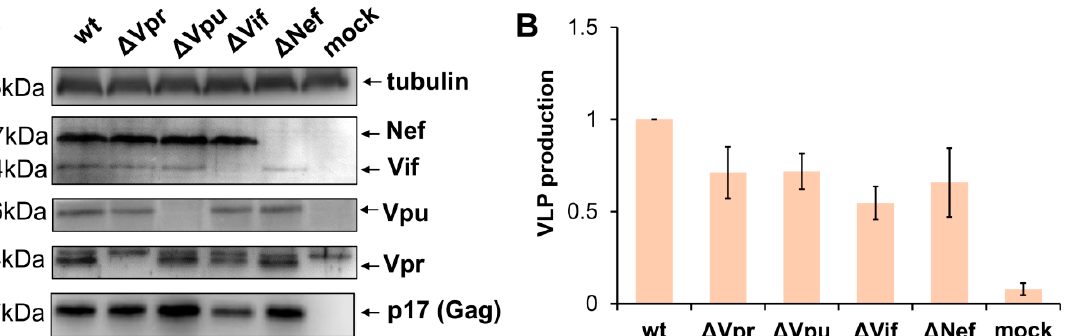
Figure 1. Characteristics of the generated accessory gene mutants of HIV-1. ( A ) Western blot analysis of HIV-1 accessory protein expression in 293T cells transiently transfected with the original (wt) pCMV-dR8.2 packaging plasmid or the plasmid containing mutation in one of the accessory genes (indicated as ∆ ) or mock plasmid. The blots were stained for viral proteins or tubulin as shown on the right. The molecular weights of stained proteins are indicated on the left. The blots with typical staining are presented. ( B ) The levels of VLP production by 293T cells transfected with wt or mutant HIV-1 packaging plasmid. The supernatants from transfected cells were harvested 48 h post-transfection, filtered, and analyzed using p24 ELISA Kit. The data obtained from the three independent experiments were calculated relative to wt control, and presented as the average values with the standard deviations.